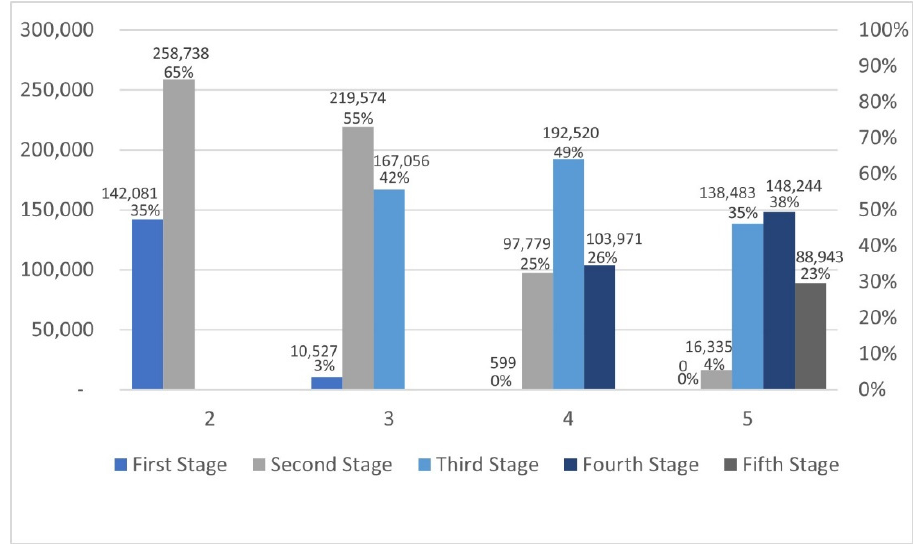
Figure 6. Percent of rejections of H 0 occurring at stage i with 500,000 iterations.